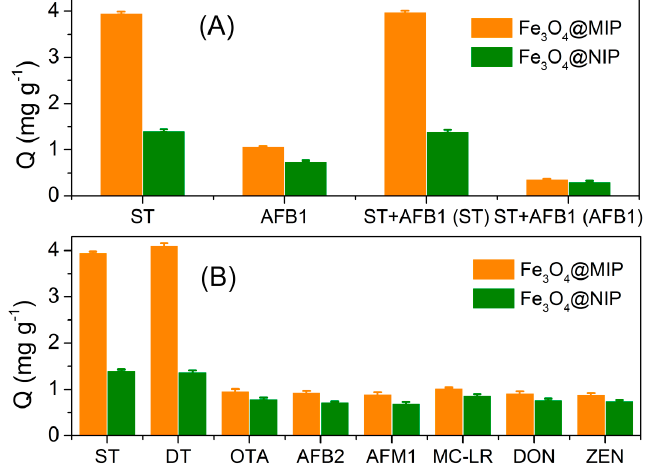
Figure 5. ( A ) Selective and competitive adsorptions of ST and AFB1 by Fe 3 O 4 @MIPs and Fe 3 O 4 @NIPs; and ( B ) specificity of the developed MIP HPLC method for ST determination. Table 2. Comparison of the developed magnetic MIP method with the previously-reported methods for ST determination.